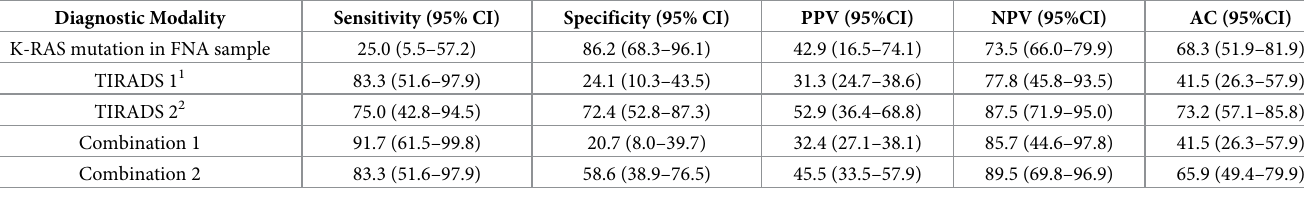
Table 4. Diagnostic performance of K-RAS mutation, ACR TIRADS and